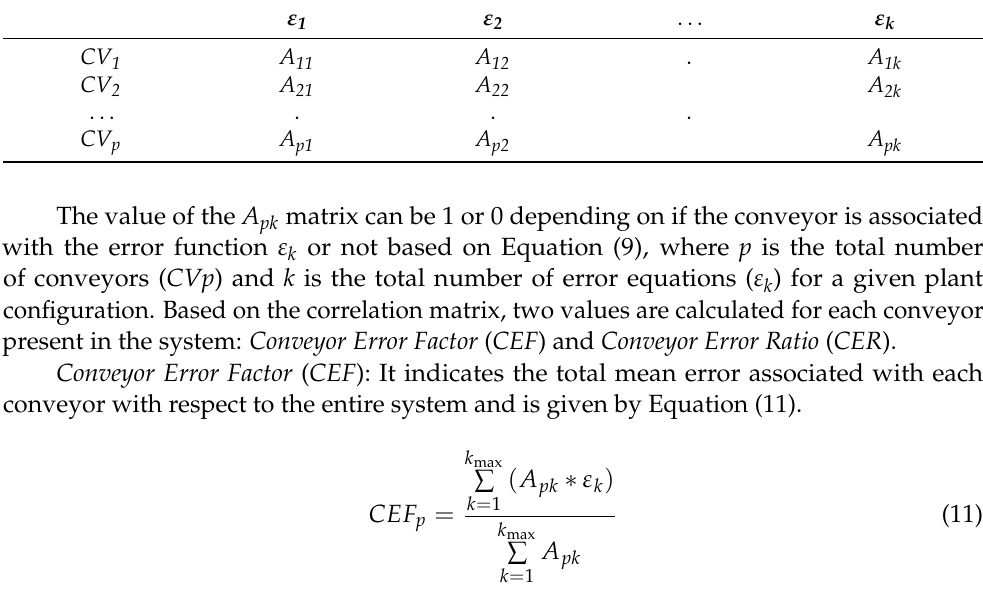
Table 1. Correlation matrix between the conveyor mass flow and error function. ε 1 ε 2 . . . ε k CV 1 A 11 A 12 . A 1k CV 2 A 21 A 22 A 2k . . . . . . CV p A p1 A p2 A